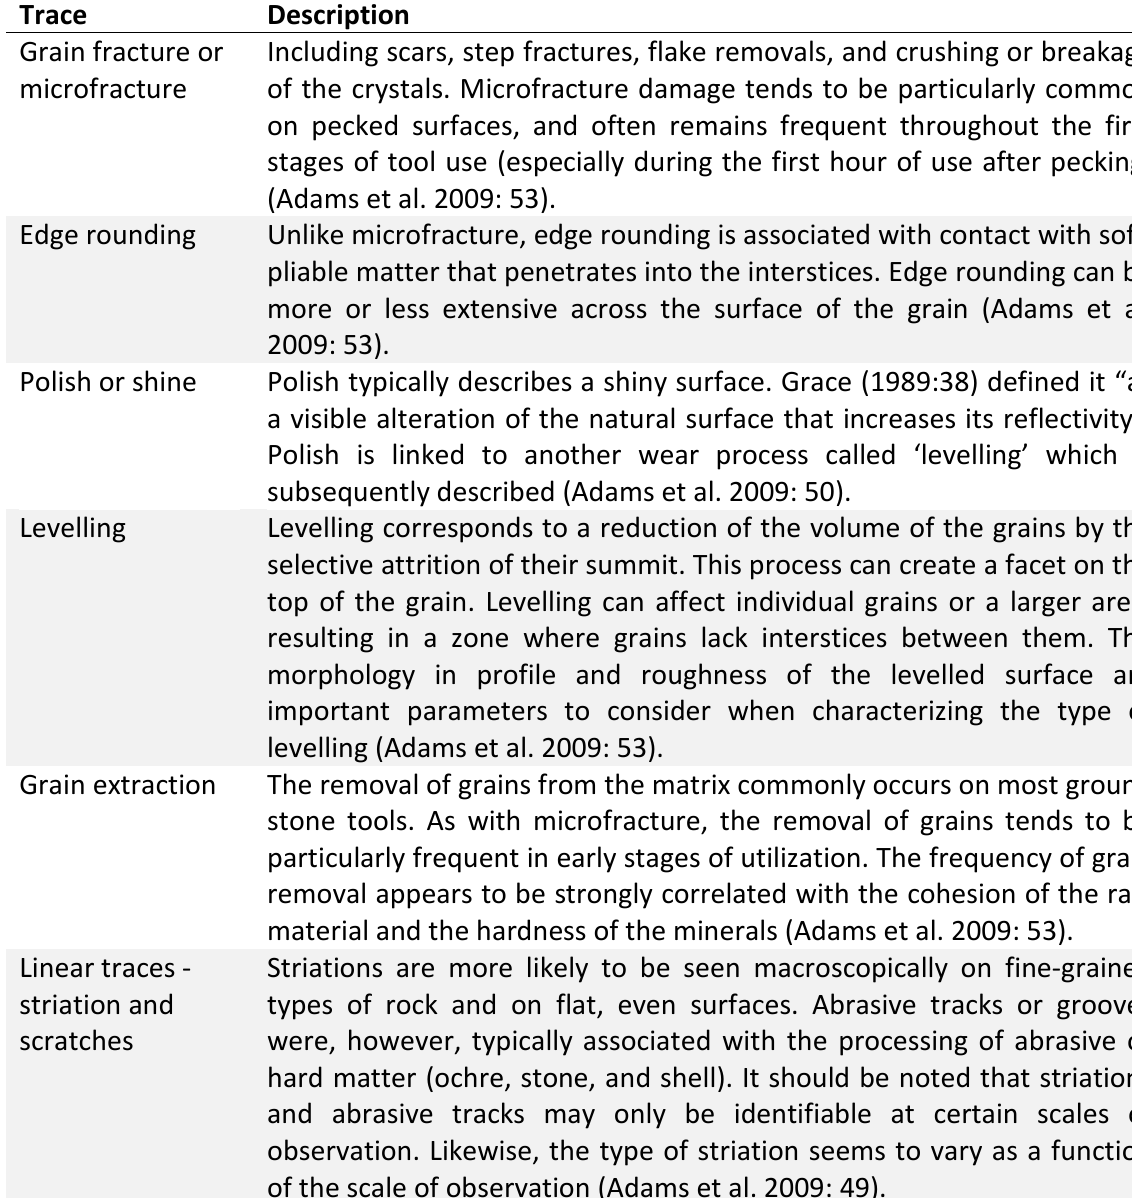
Table 2. Summary of descriptions of the macroscopic and low magnification traces as defined by Adams et al. (2009). Microwear traces observed on groundstone